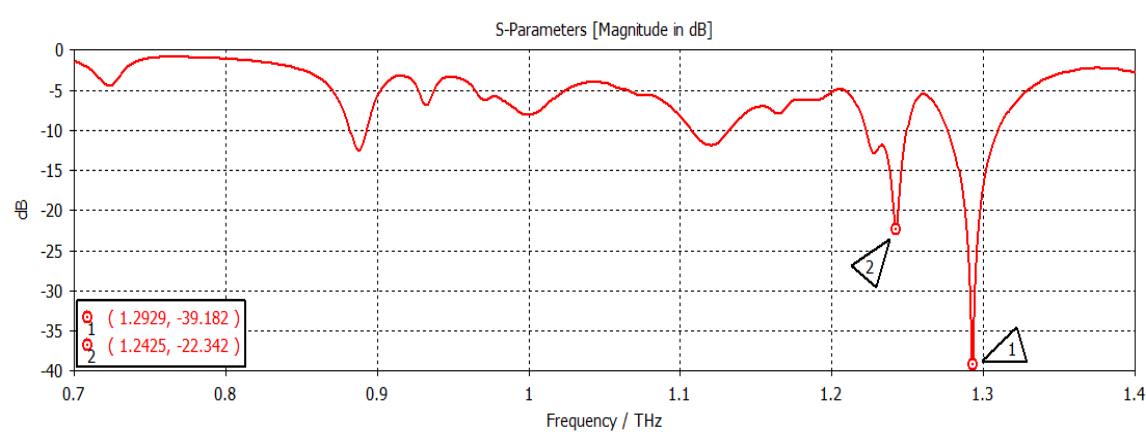
Figure 13. w 1 = 100 µm and z 1 = 300 µm.